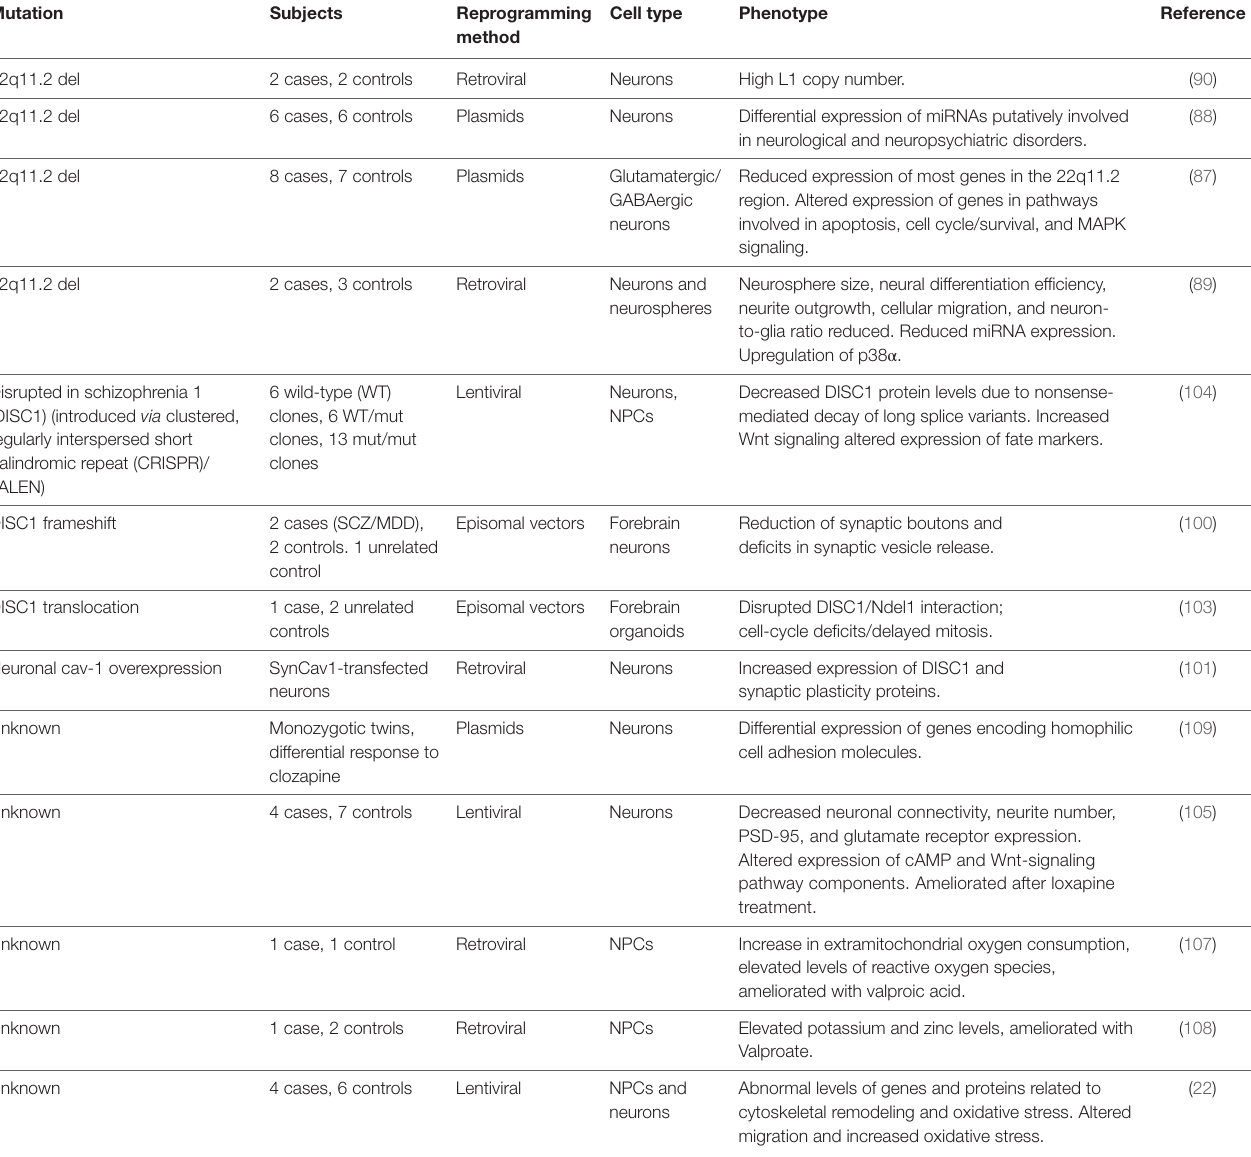
TABLe 1 | Studies of human-induced pluripotent stem cell models of